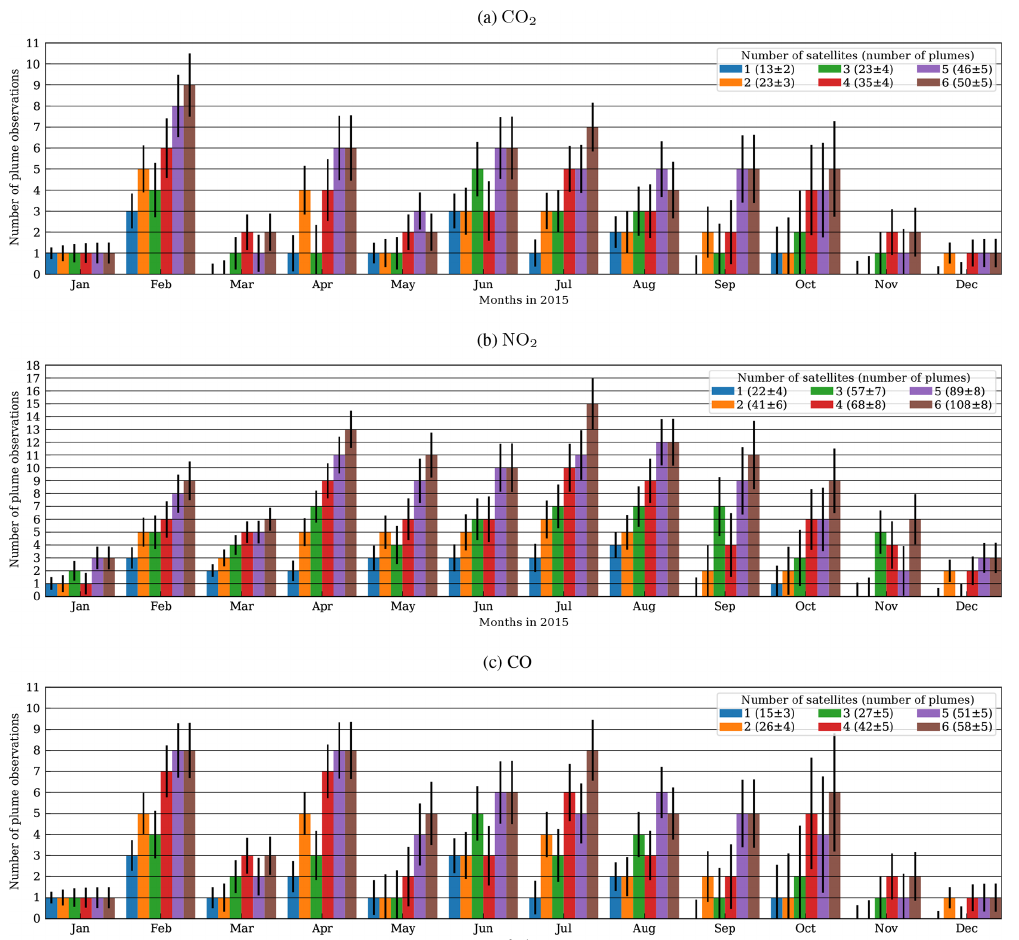
Figure 6. Number of cloud-free plumes of the city of Berlin with at least 100 pixels per month for (a) CO 2 , (b) NO 2 and (c) CO. The cloud threshold is 1% for CO 2 , 30% for NO 2 and 5% for CO observations. Error bars are obtained by comparing all available satellites. The number of expected plumes per satellite is 8, 17 and 9 for the CO 2 , NO 2 and CO instrument, respectively.